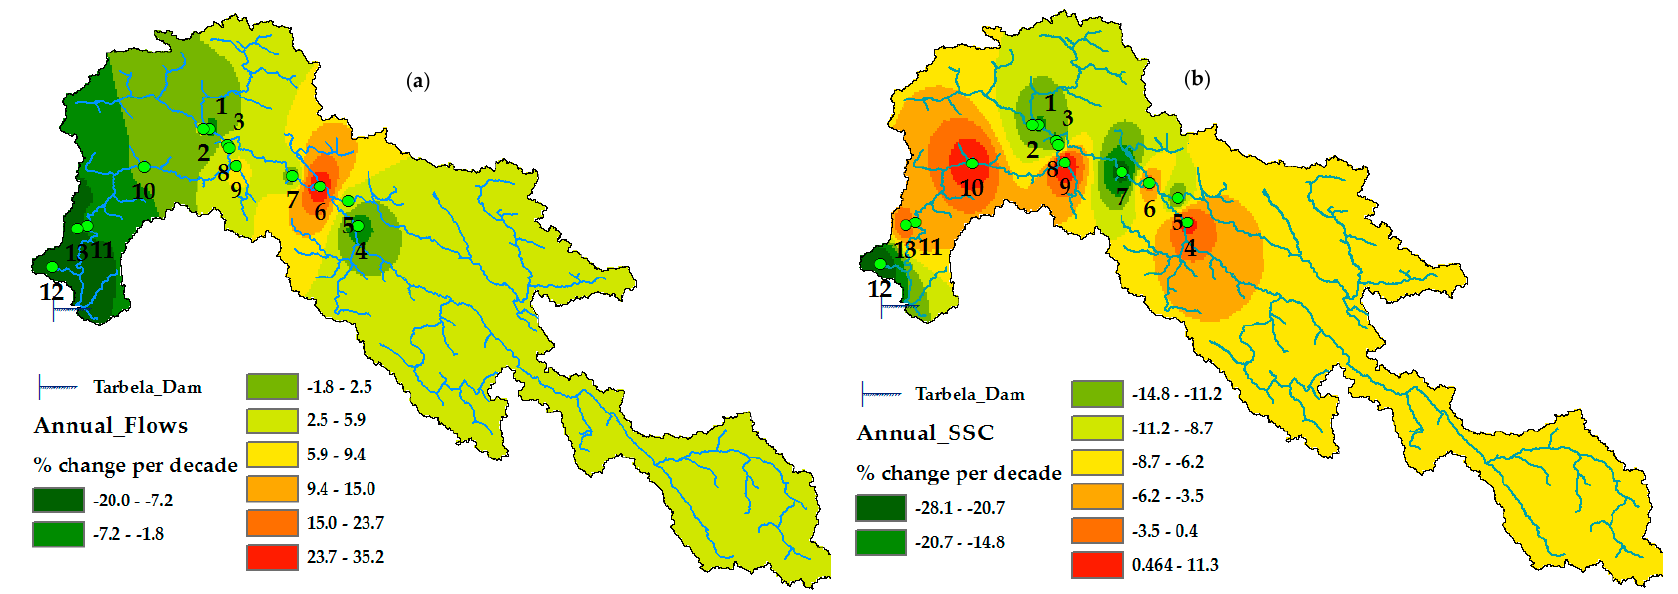
Figure 4. Annual flow and suspended sediment concentration (SSC) trends spatially distributed over the basin with % of changes per decade in % of mean values for the whole period. ( a ) Annual flows, ( b ) annual SSC. Please correct in the figure: Change per Decade!